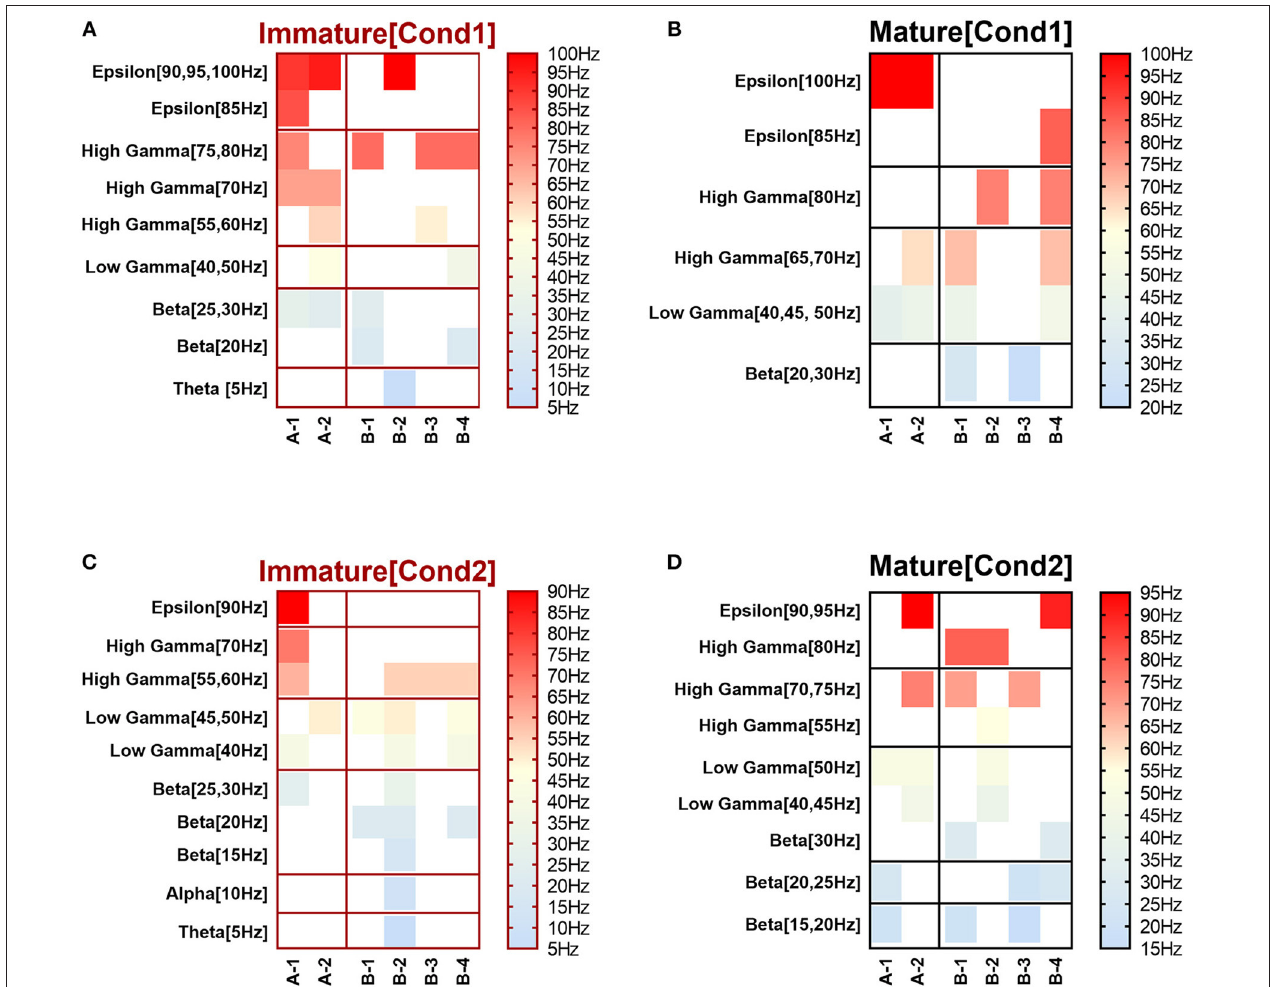
FIGURE 1 | Selected input frequencies [IF (Hz)] that succeeded across all network scenarios of both conditions: immature (A,C) and mature networks (B,D) , in triggering modulation effect after implementing depressing and facilitating dynamical synapses. Ranges are theta [3–7Hz], alpha [7–12Hz], beta [12–30Hz], gamma (low [30–50Hz] and high [50–80Hz]), and epsilon [80–250Hz] (throughout Figure 3A of Ji et al., 2013). (A,B) refer to condition 1, which indicates the predicted modulated responses (in response to STP) while (C,D) relate to condition 2 (unpredicted modulated responses in response to